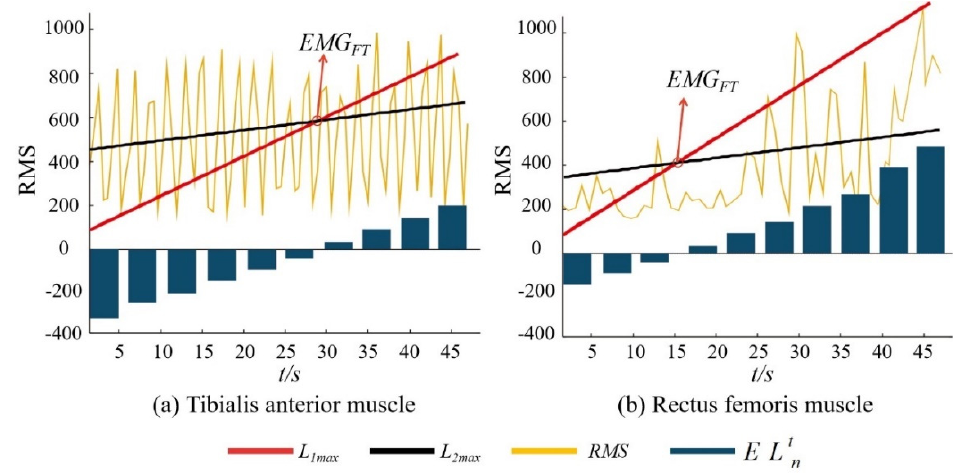
Figure 4. The result of improved EMG FT fatigue level determination algorithm.